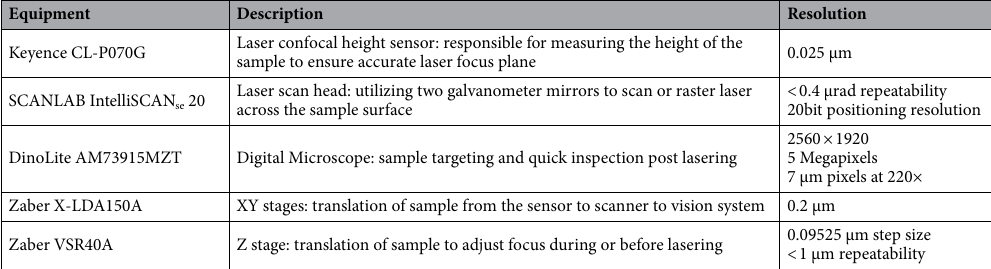
Table 2. Description and resolution of major components of the laser system.